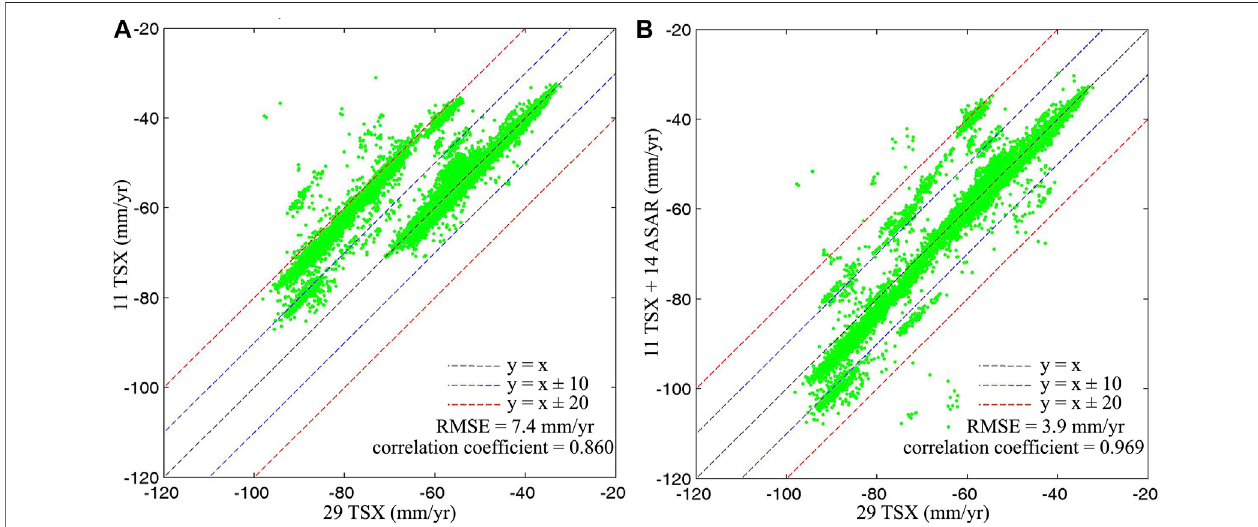
FIGURE8| Comparison betweendeformationratesderived from 29TSX acquisitions and (A) 11TSX acquisitionsusing standard StaMPS-SB and (B) integration of 11 TSX acquisitions and 14 ASAR acquisitions using the proposed method.